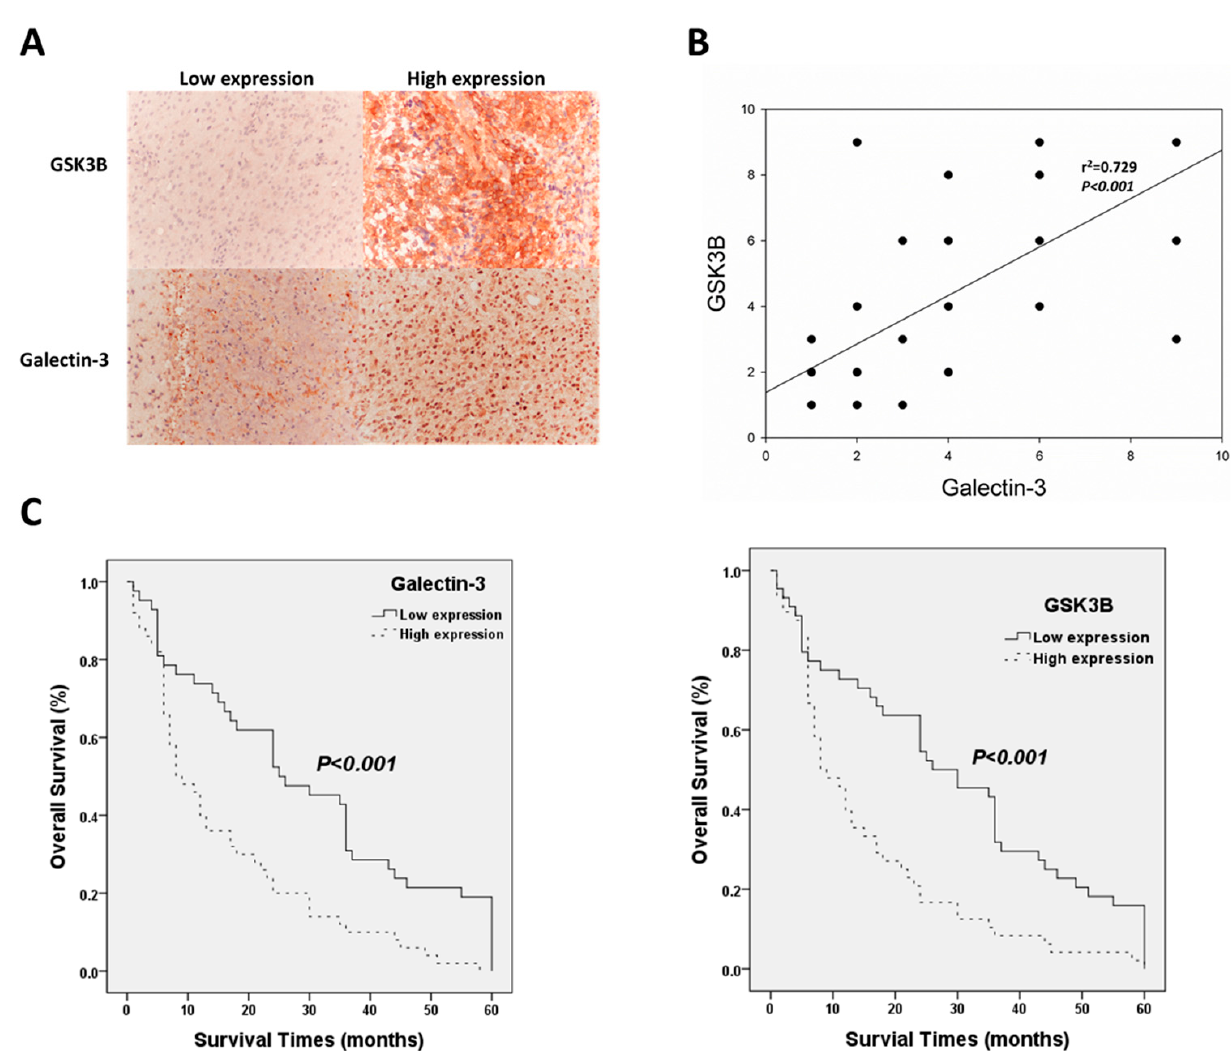
Figure 1. Clinic-pathological role of galectin-3/GSK3B in astrocytoma patients. ( A ) Representative results of immunohistochemical staining for galectin-3/GSK3B using samples obtained from patients with different immunohistochemical staining scores; Magnification is 100 × . ( B ) Correlation between galectin-3 and GSK3B expression and survival outcomes. ( C ) Analysis of galectin-3 and GSK3B protein expression using Kaplan − Meier